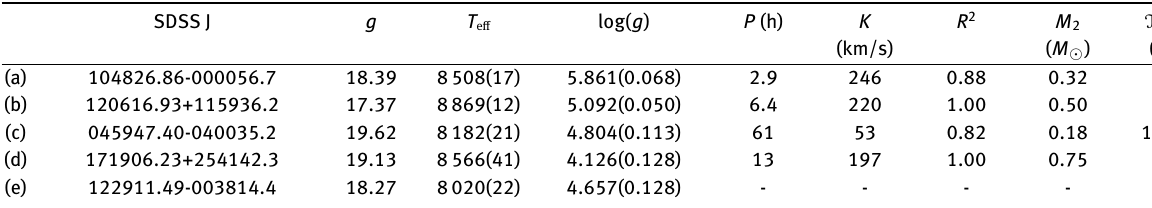
Table 1. Atmospheric and orbital parameters obtained for the objects shown in Figures 10 and 11, assuming the solar abundance models. Quoted uncertainties in our values of T eff and log g are formal fit errors. The external uncertainties in the models are much larger, of about 5–10 per cent in T eff and 0.25 dex in log g . The orbital parameters are for the best solution, but some objects might need follow-up (see text for discussion). The secondary mass M 2 is the minimal mass assuming an edge-on orbit.